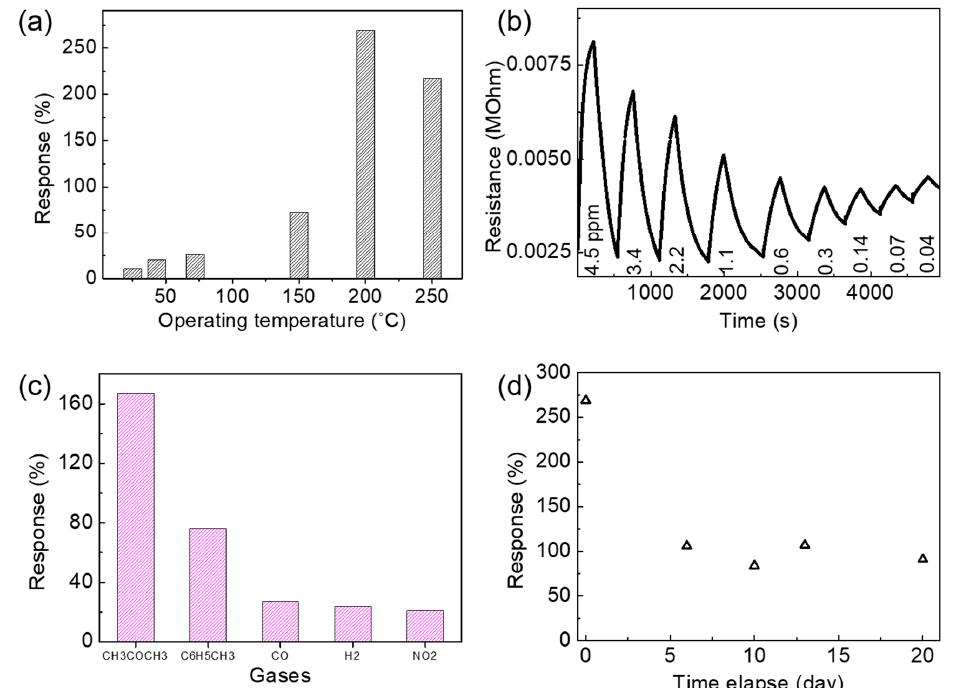
Figure 8. Sensing characteristics of a sensor based on Co(OH) x F 2 − x nanosheets: ( a ) responses at various operating temperatures toward 4.5 ppm of acetone gas, ( b ) resistance changes upon input of acetone gas of a various concentration at 200 ◦ C, ( c ) selectivity toward CH 3 COCH 3 (2.2 ppm), C 6 H 5 CH 3 (3.6 ppm), CO (0.8 ppm), H 2 (0.8 ppm), and NO 2 (1.1 ppm) at 200 °C, and ( d ) stability (for 20 days) toward 4.5 ppm of acetone at 200 ◦ C. Table 1. Comparison of the performances of acetone sensors using Co-based materials reported in the literature. Material Hierarchical and hexagonal Co 3 O